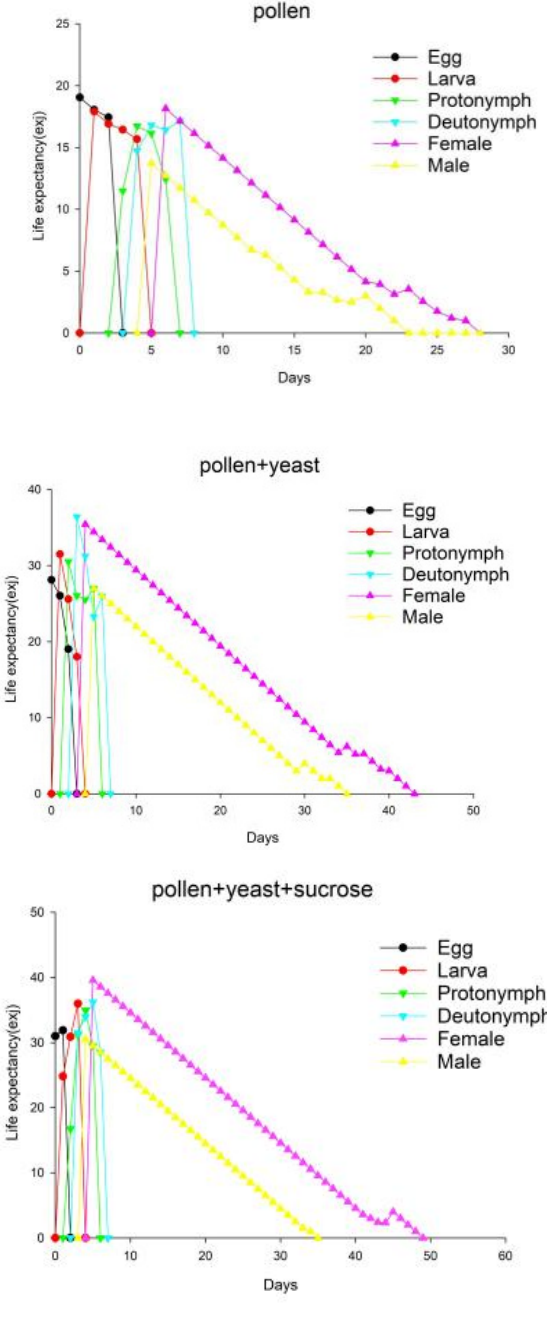
Figure 3. Life expectancy of Amblyseius orientalis individuals in three treatment groups; e xj indicates the survival probability of an individual of age x and stage j.